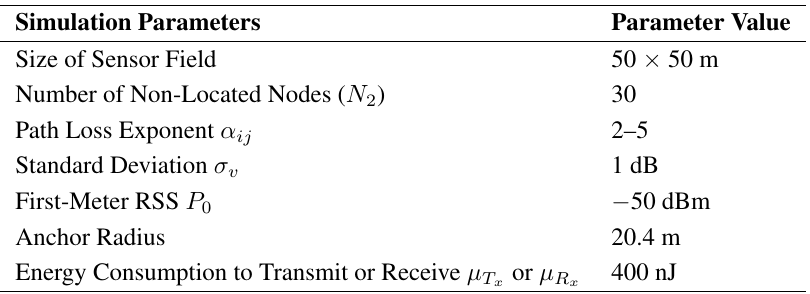
Table 1. Simulation